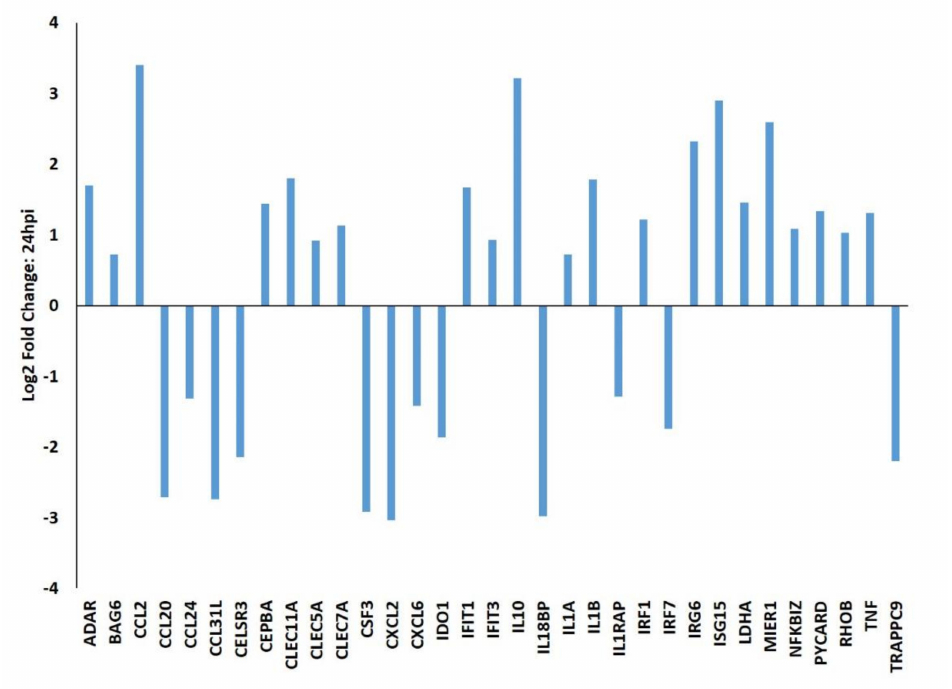
Figure 2. A selection of di ff erentially expressed genes in PRRSV-infected macrophages at 24 hpi. PAMs ( n = 3) were either infected with PRRSV strain VR-2332 or mock infected and total RNA was collected at 24 h and subjected to RNA-sequencing. All values are provided as the log 2 fold di ff erences of gene expression levels in PRRSV-infected PAMs relative to mock-infected PAMs. All genes shown were statistically significantly di ff erent (FDR-corrected p < 0.05) between the